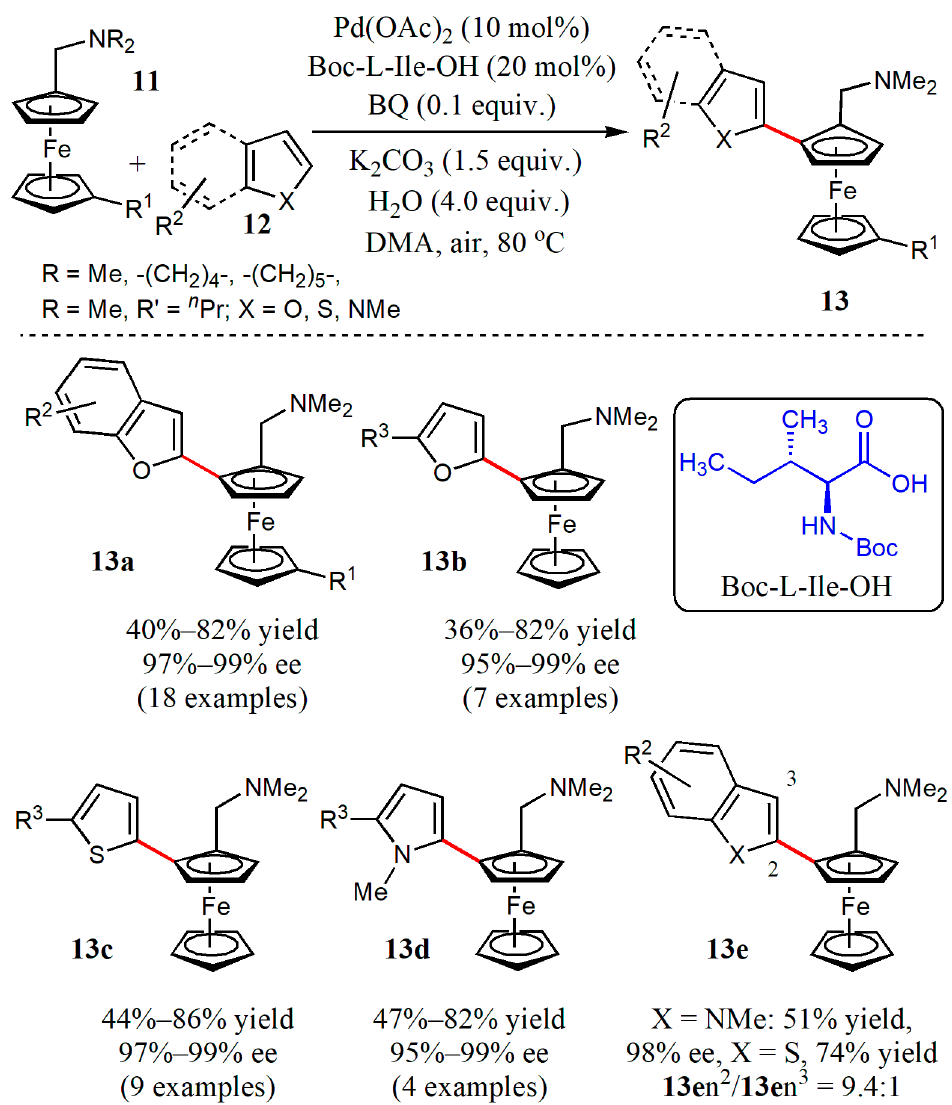
Figure 5. Synthesis of planar chiral ferrocenes by enantioselective CDC. BQ = benzoquinone.